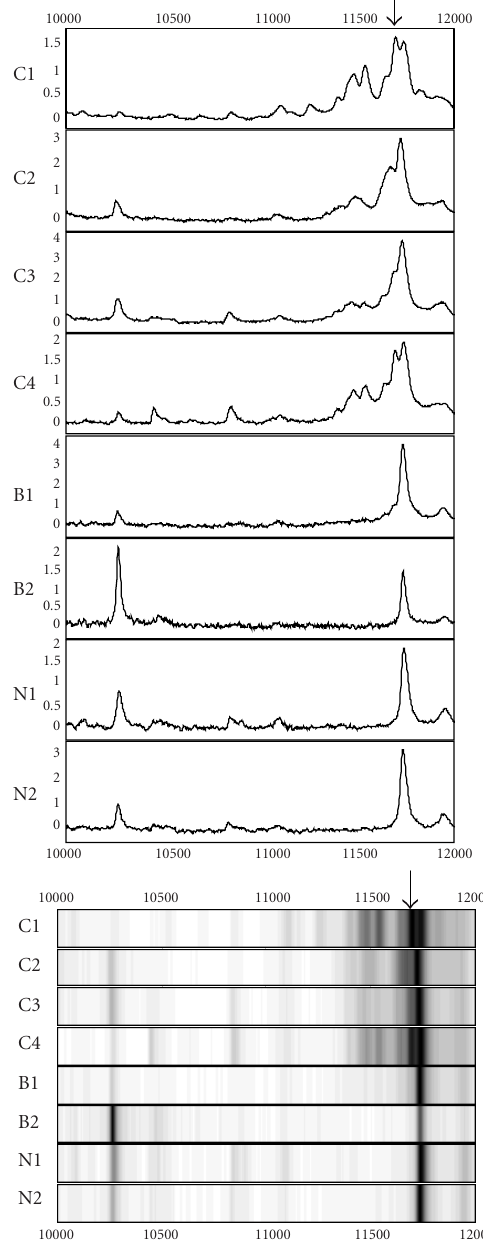
Figure 4. Spectra (top) and grey-scale or gel views (bottom) of the peaks (arrows) forming the splitting rules. The protein peak was detected on IMAC chip. The peak appears to be downregu- lated in the cancers.